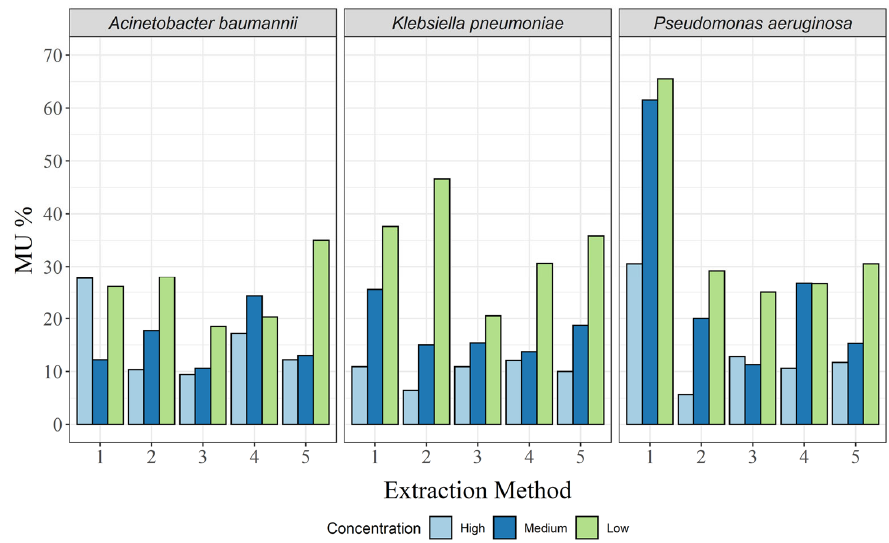
Figure 4. Relative expanded (k = 2) measurement uncertainty for each of the three bacterial species and for all extraction methods: 1, CTAB; 2, QIAamp DNA mini kit; 3, GXT NA extraction kit; 4, QuickPick genomic DNA extraction kit; 5, DNeasy UltraClean microbial